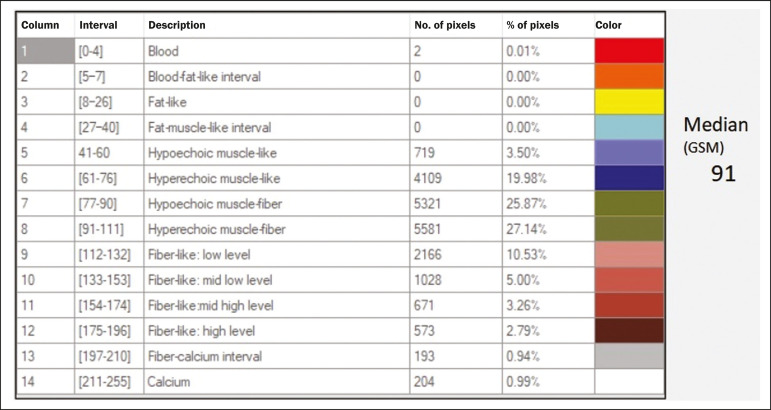
Pixel brightness ranges and the probable corresponding tissues on ultrasound.